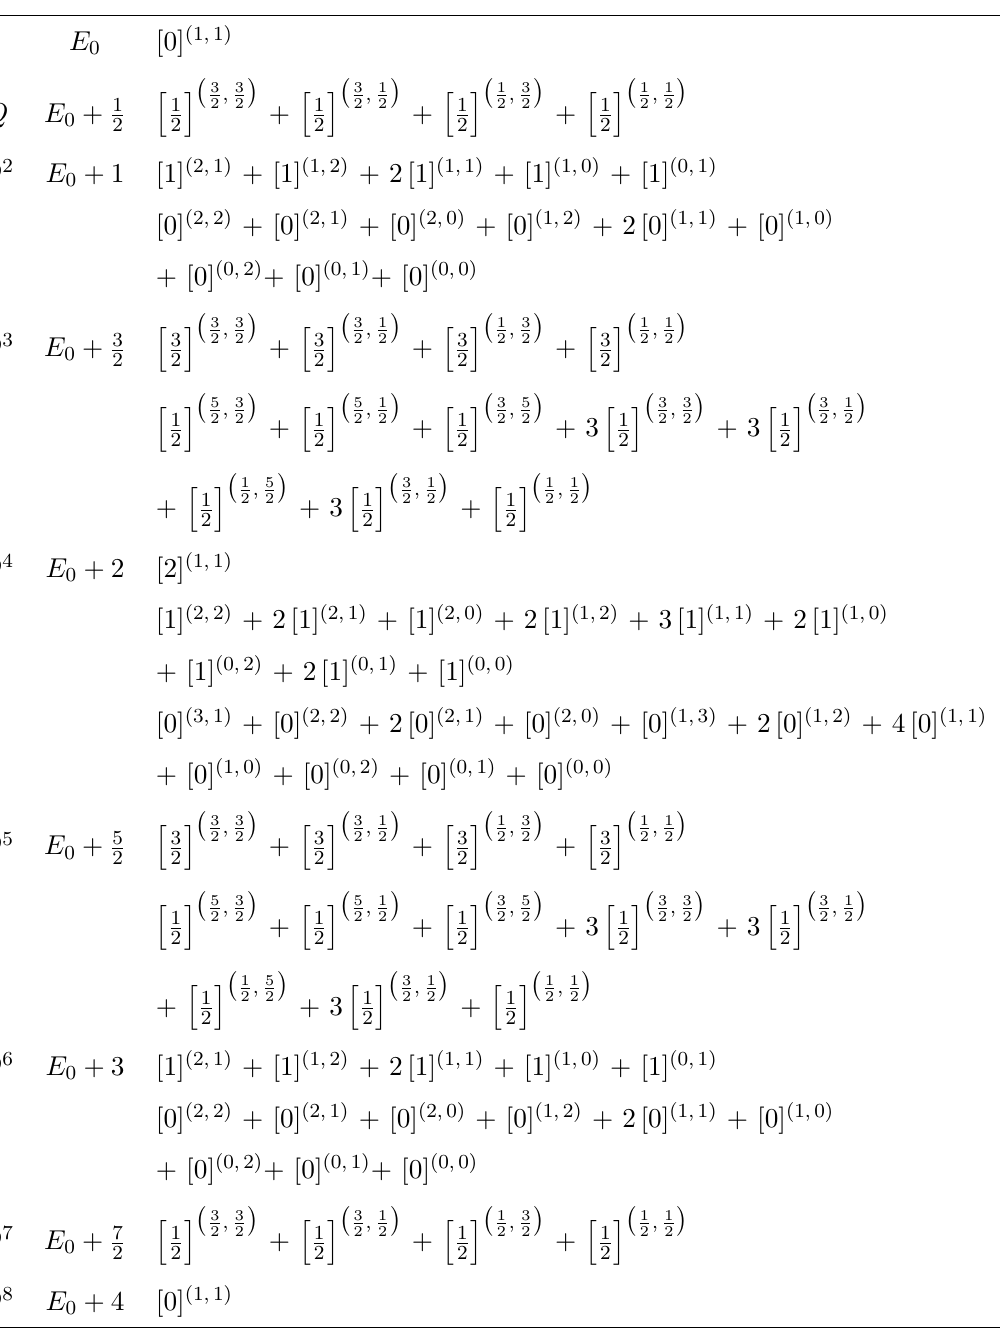
Table 8 . States in the long graviton supermultiplet LGRAV 4 [ E 0 , 1 , 1]